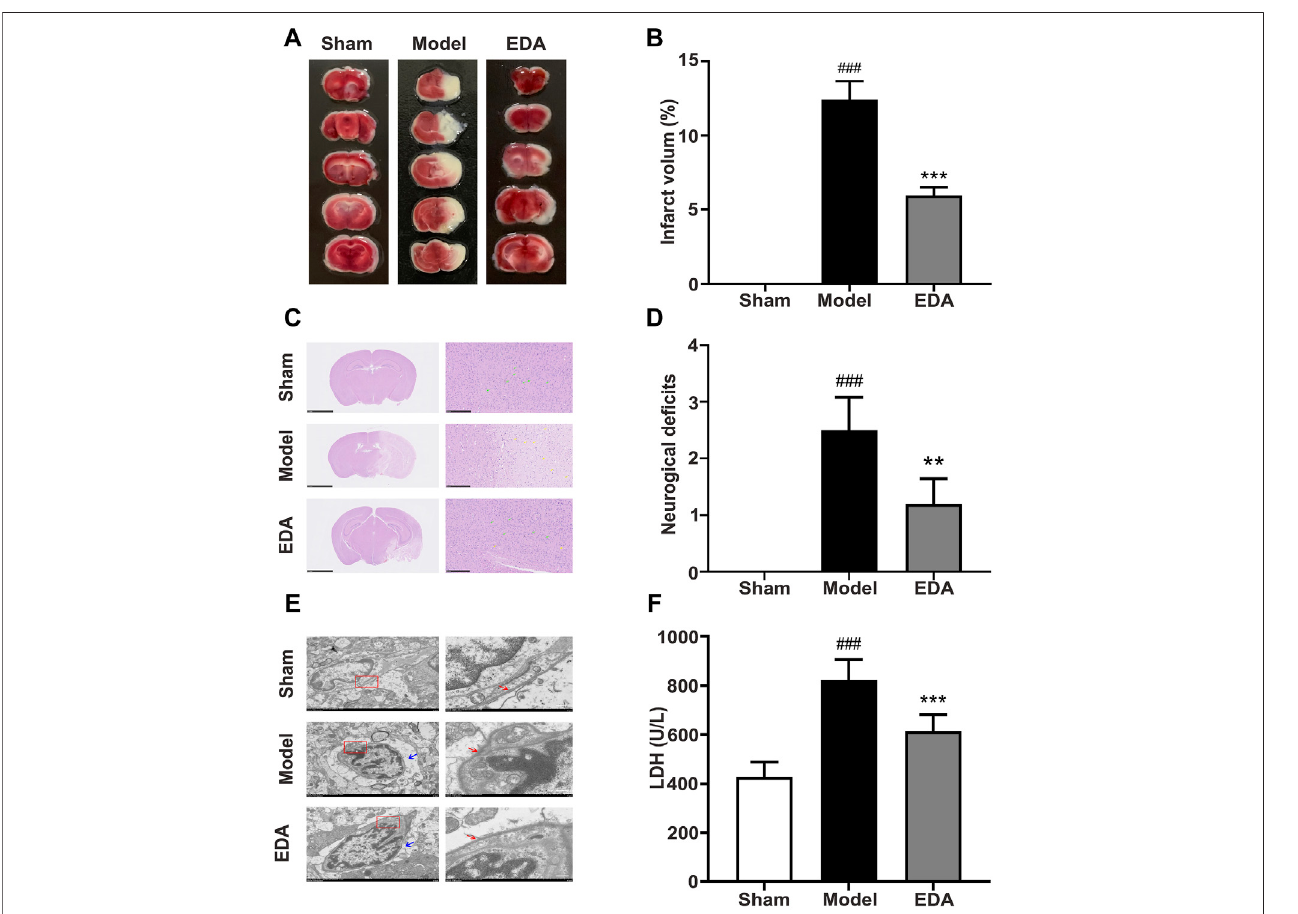
FIGURE 1 | EDA protects against cerebral I/R injury and endothelial injury. Mice were subjected to 1 h of ischemia, followed by 24 h of reperfusion. EDA (3 mg/kg) wasadministered intraperitoneallyafter ischemia. (A) RepresentativeTTC-stained brainsections. (B) Quantitative analysisofinfarct volume. (C) Stained H&Esectionsof mice brains. Shrunken cells with pyknotic nuclei are indicated with yellow arrows, while intact cells are indicated with green arrows. (D) Neurological de fi cit scores in different groups. (E) The structure and morphology of cerebral microvascular endothelial cells in different groups were examined by electron microscopy. Red arrow: brain microvascular endothelial cell membrane. Blue arrow: the degree of edema around brain microvascular endothelial cells. (F) LDH activity. All data are presented as the means ± SEM, n = 6. Scale bar = 50 μ m. # p < .05, ## p < .01, ### p < .001, vs . Sham group, * p < .05, ** p < .01, *** p < .001, vs . MCAO/R group.